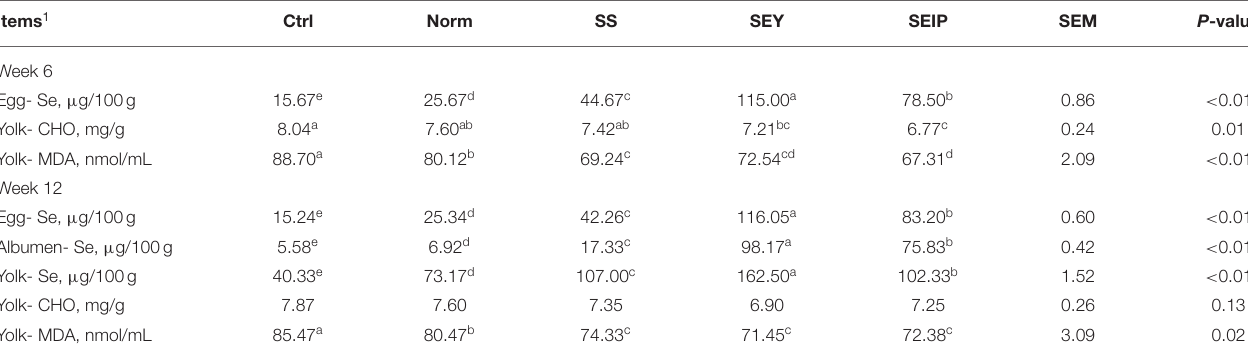
TABLE 4 | Effects of dietary Se sources on the concentration of Se, cholesterol, and malondialdehyde of eggs in laying hens. Items